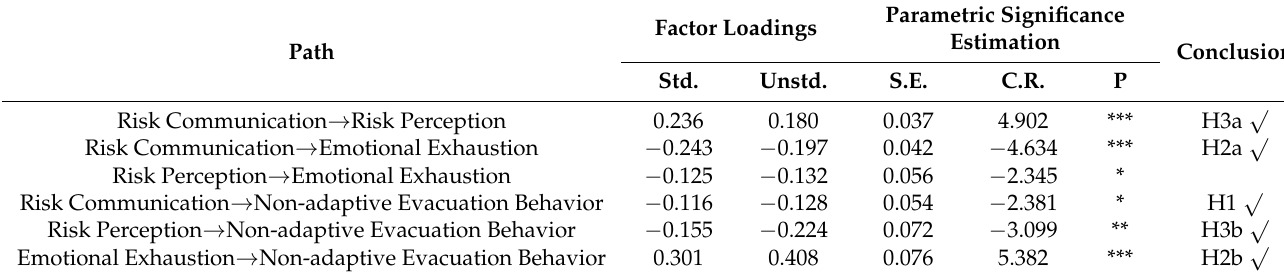
Figure 2. Structural equation model analysis results. Table 5. Direct action checklist.